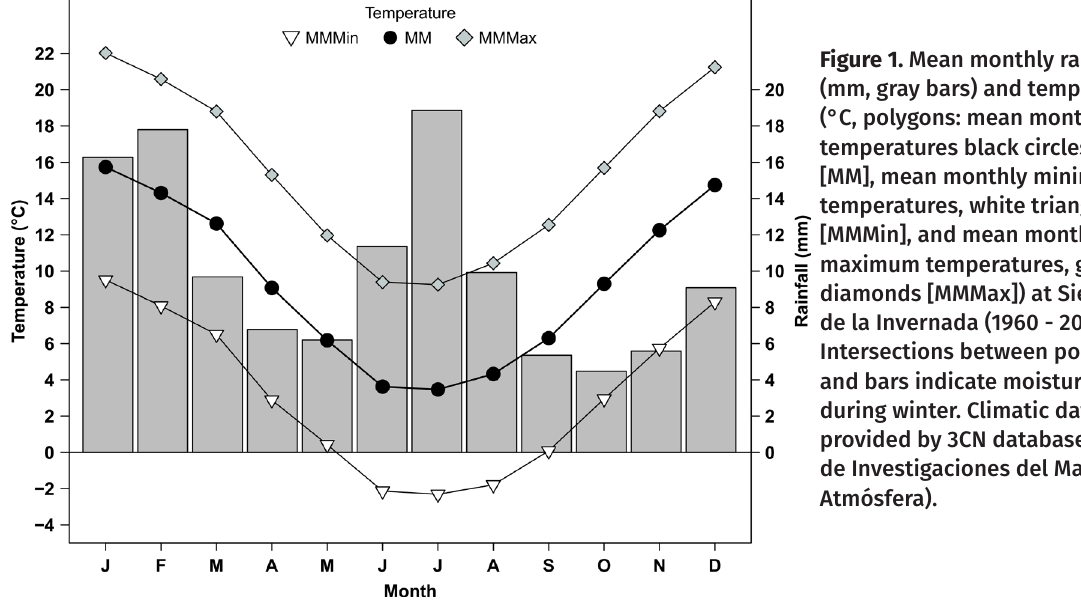
Figure 1. Mean monthly rainfall (mm, gray bars) and temperatures (°C, polygons: mean monthly temperatures black circles [MM], mean monthly minimum temperatures, white triangles [MMMin], and mean monthly maximum temperatures, grey diamonds [MMMax]) at Sierra de la Invernada (1960 - 2010). Intersections between polygons and bars indicate moisture surplus during winter. Climatic data provided by 3CN database (Centro de Investigaciones del Mar y